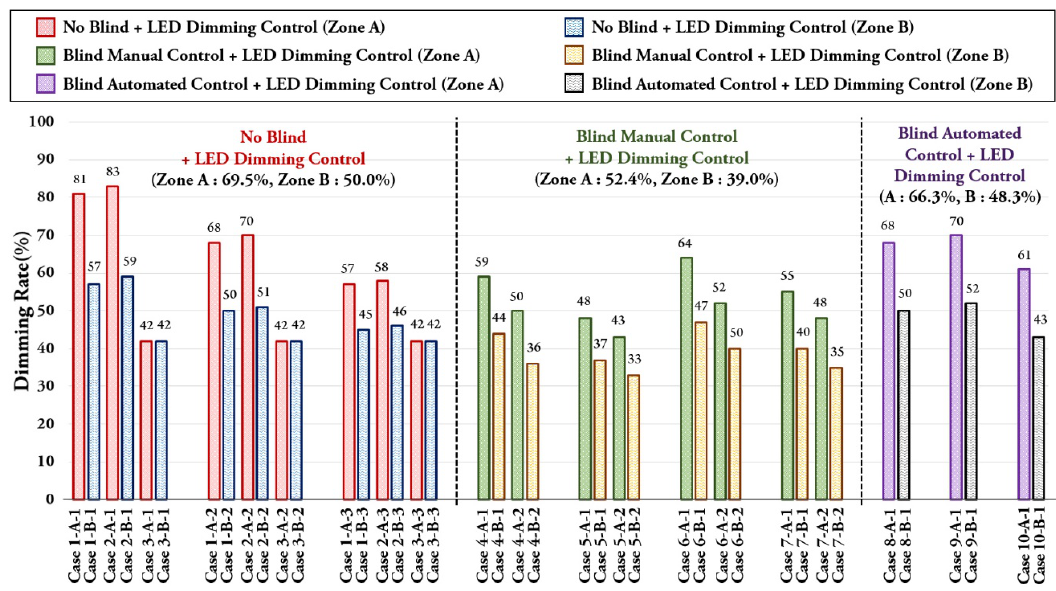
Figure 23. Average dimming rates of Zone A and Zone B by case under integrated blinds and dimming controls.